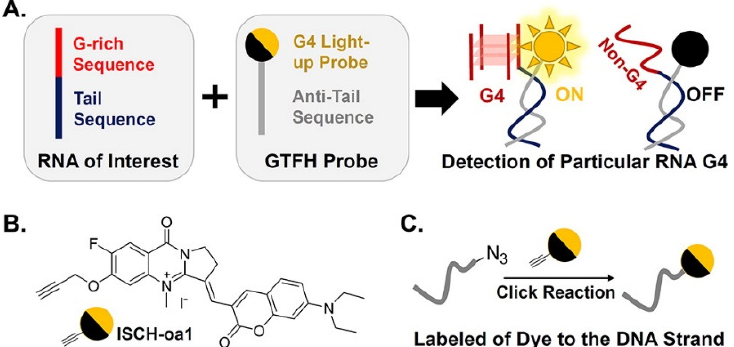
Figure 9. Schematic representation of GTFH probe. ( A ) GTFH probe design principle. ( B ) Chemical structure of ISCH-oa1. ( C ) GTFH probe preparation. Reprinted with permission from ref. [117]. Copyright 2016 American Chemical Society.